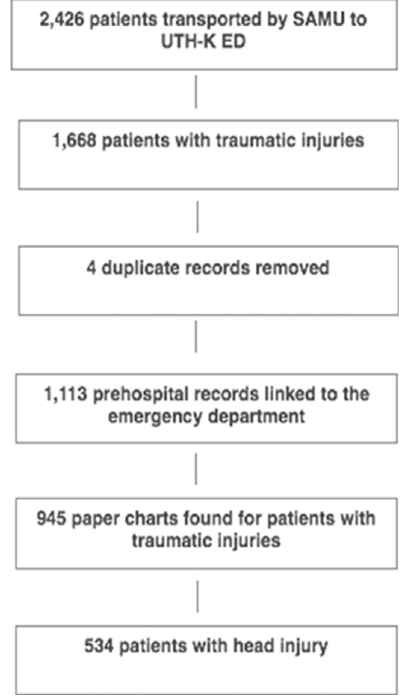
Figure 1. Flow diagram of patient enrollment.